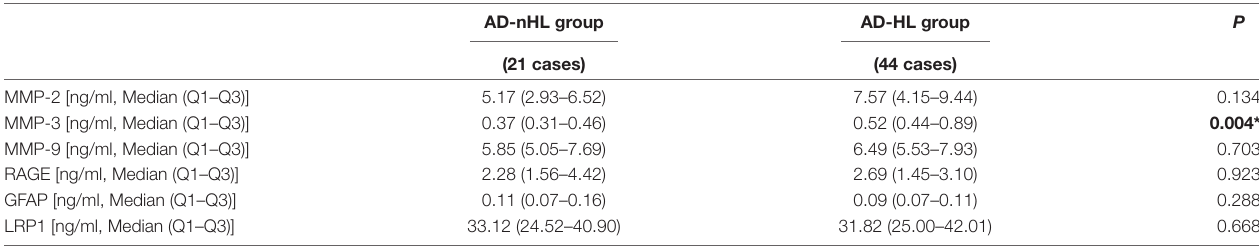
TABLE 6 | Levels of blood-brain barrier (BBB) factors in CSF from AD-nHL and AD-HL